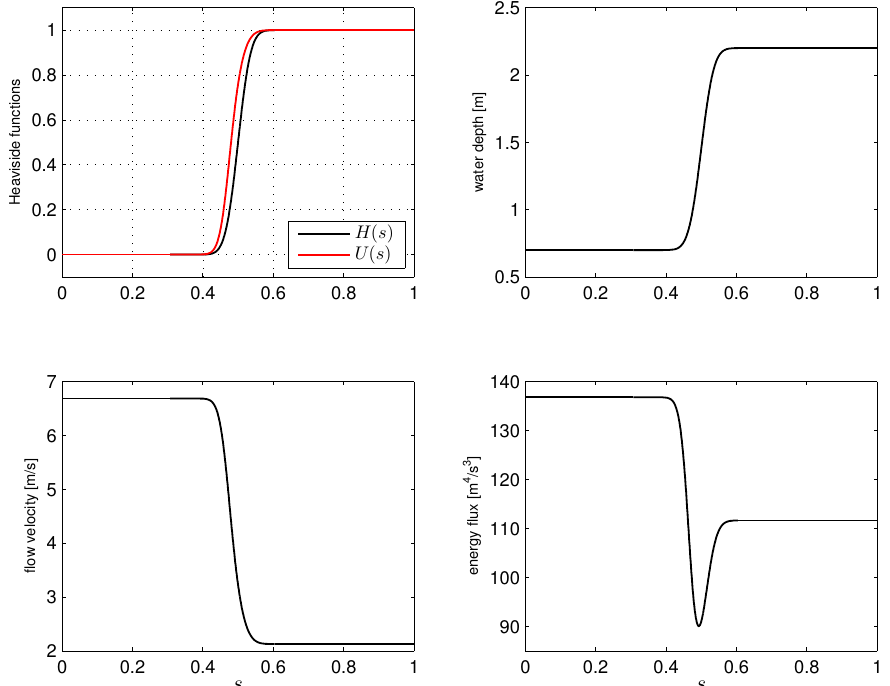
Figure 3. Heaviside functions and flow profiles across infinitesimal hydraulic jump with thickness of unity for m = 25. Function H is based on the error function, while function U is computed with Equation